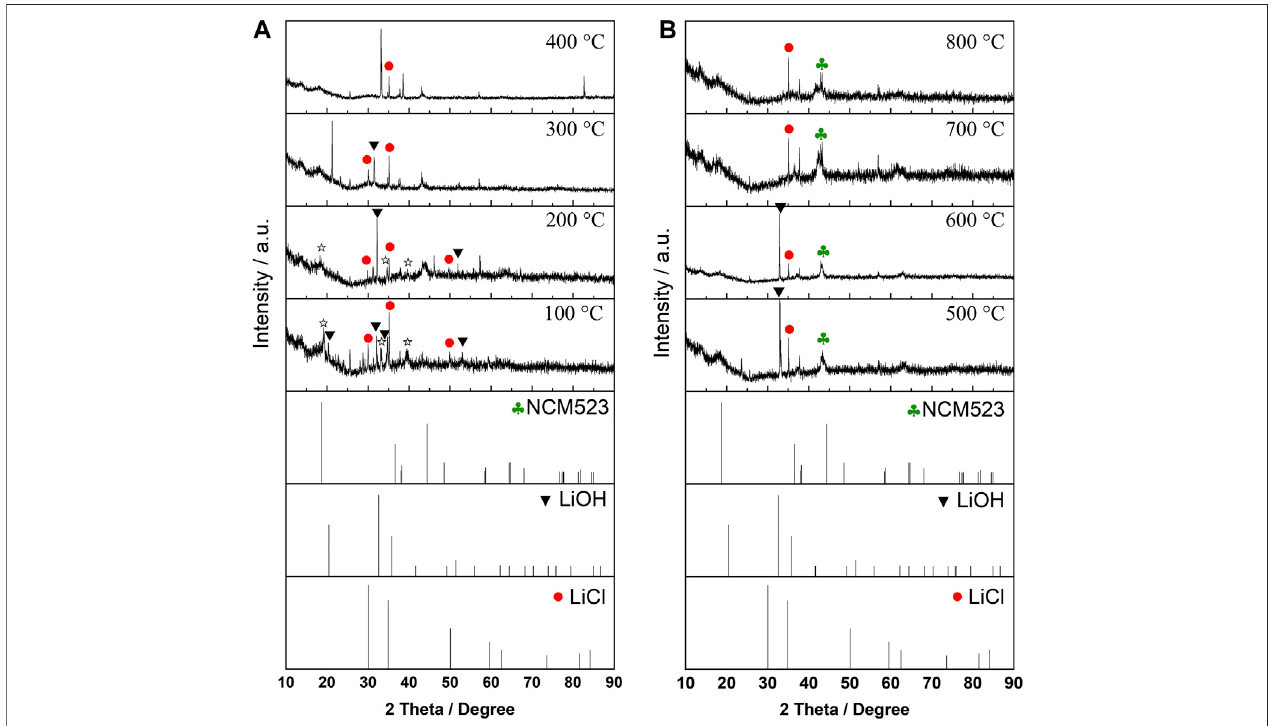
FIGURE 2 | Temperature-dependent XRD patterns measured upon heating of lithium and precursor mixture in a temperature range from 100 ° C to 800 ° C.